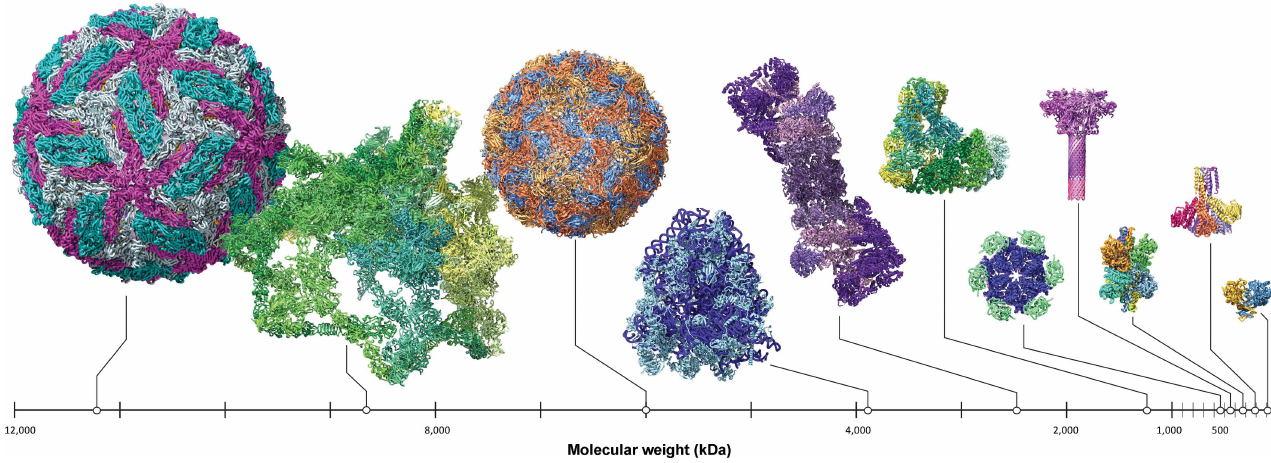
Figure 1 From large to small: the growing diversity of cryo-EM